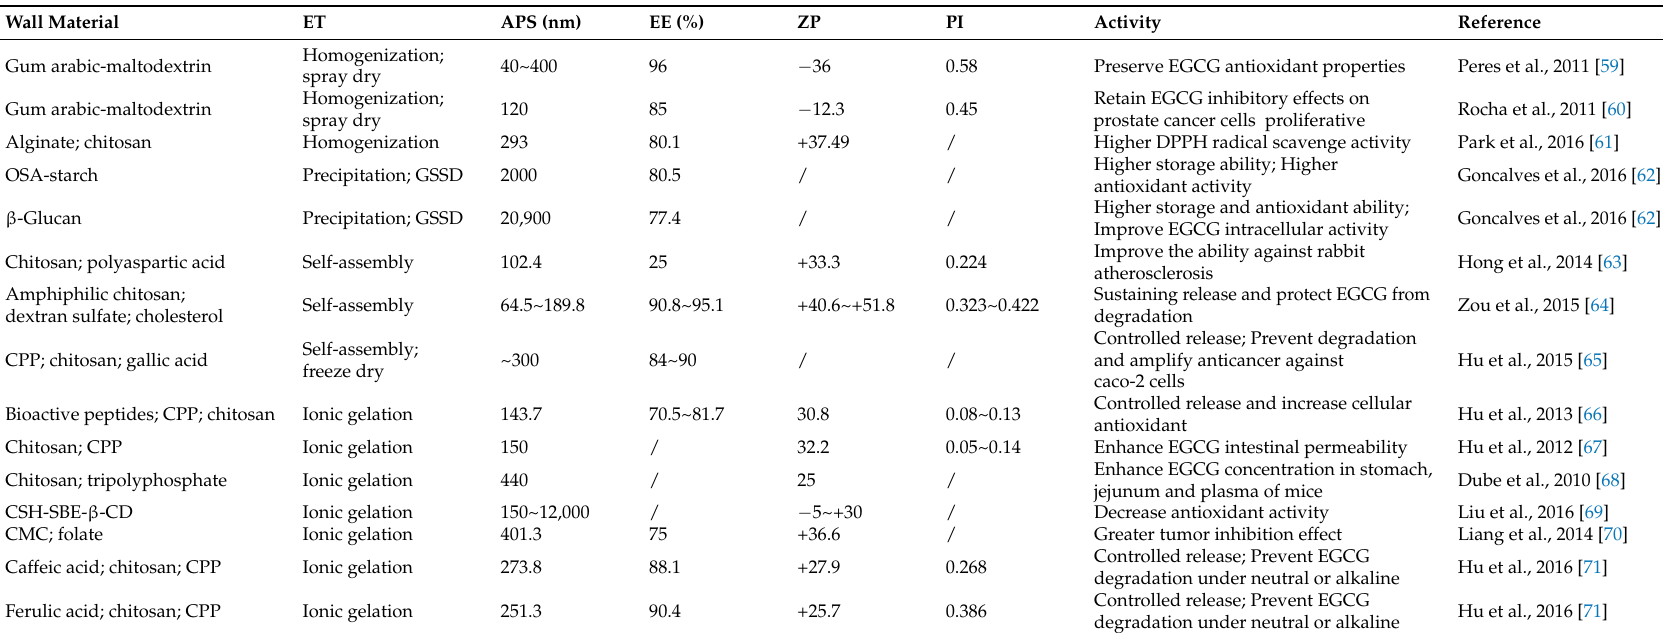
Table 2. Overview of studies on the effect of carbohydrates based encapsulation on